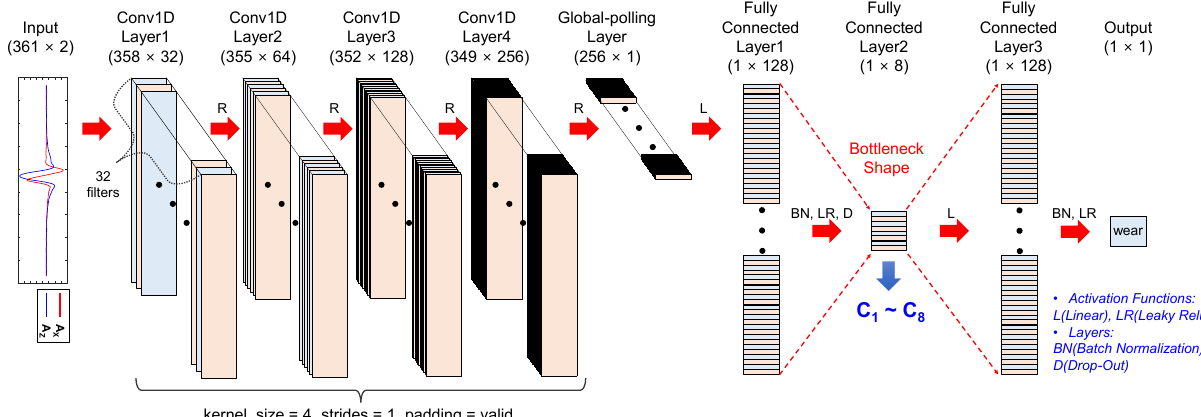
Figure 8. 1D-CNN to extract eight bottleneck features for predicting the amount of tire wear.